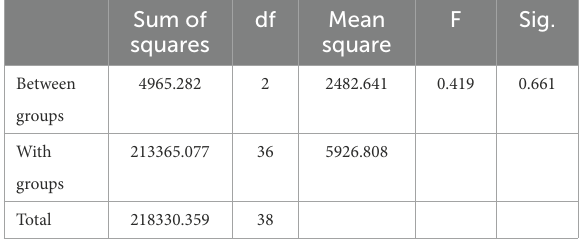
TABLE 5 The differences in the use of modal verbs in the three translations.